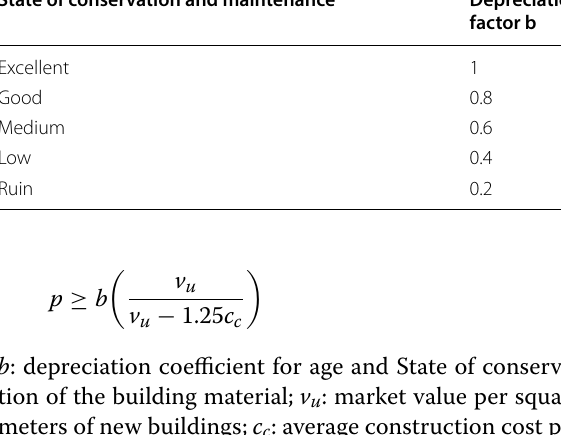
b : depreciation coefficient for age and State of conserva-